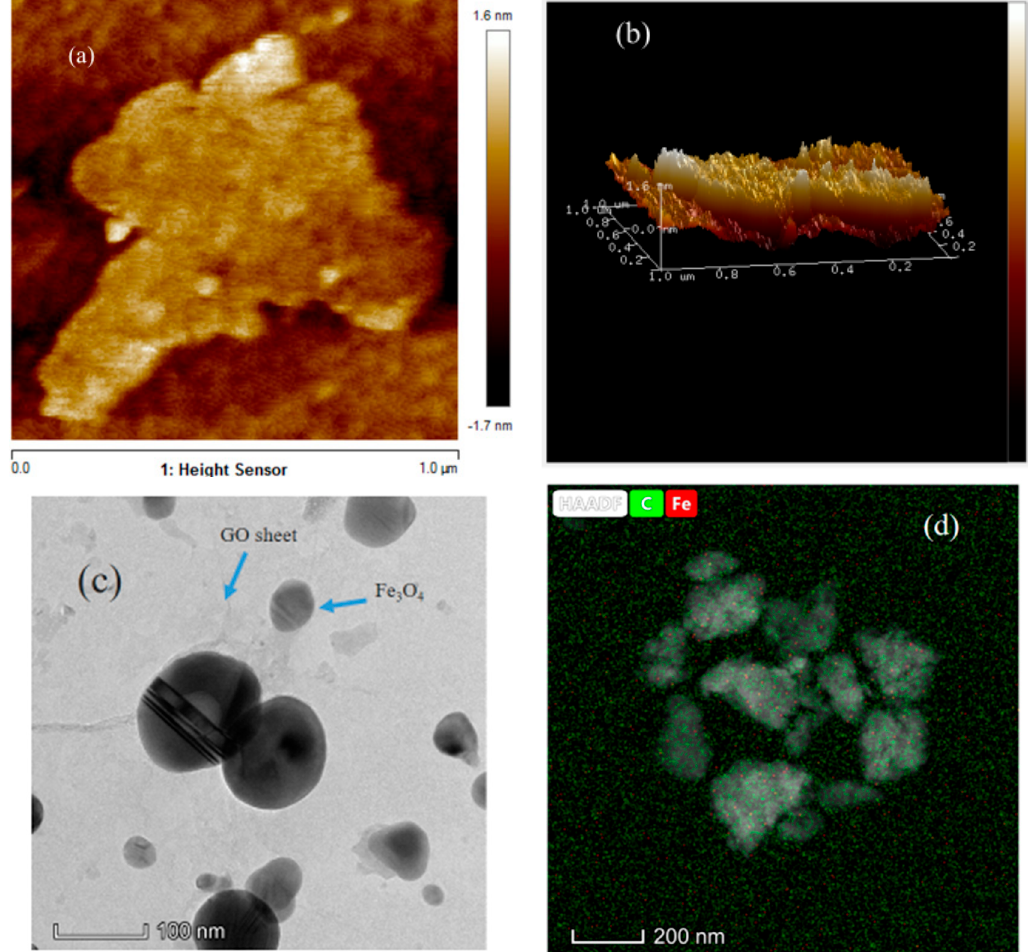
Figure 3. ( a , b ) Alternating magnetic field (AFM) images of 40 h milled GO-Fe with composition 50:50. ( c ) Bright field TEM images of 40 h milled sample. ( d ) Representative compositional mapping result obtained from the region of interest.